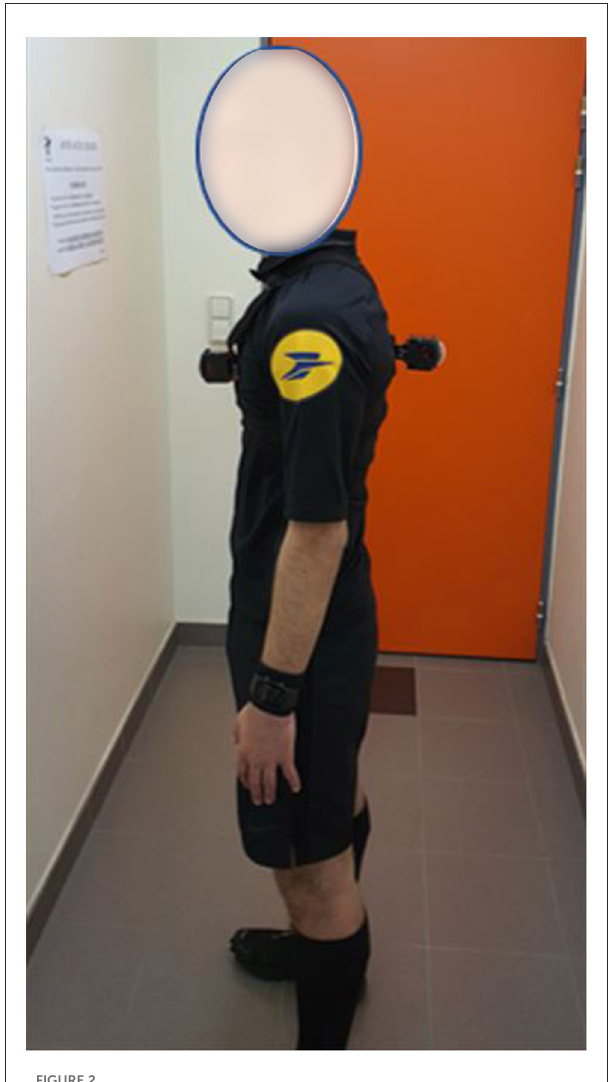
FIGURE2 Profile view of the waistcoat and the support used to fix the camera.